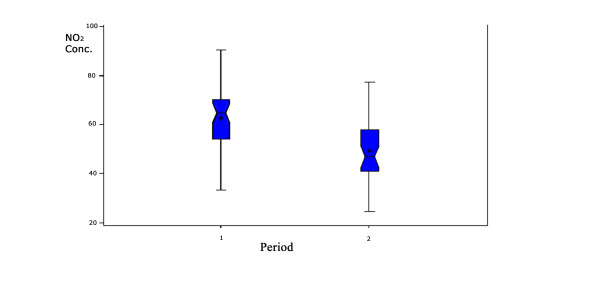
Mean NO2 levels in the first and second periods of measurement. (p = 0.05) Period 1 = July; Period 2 = August.